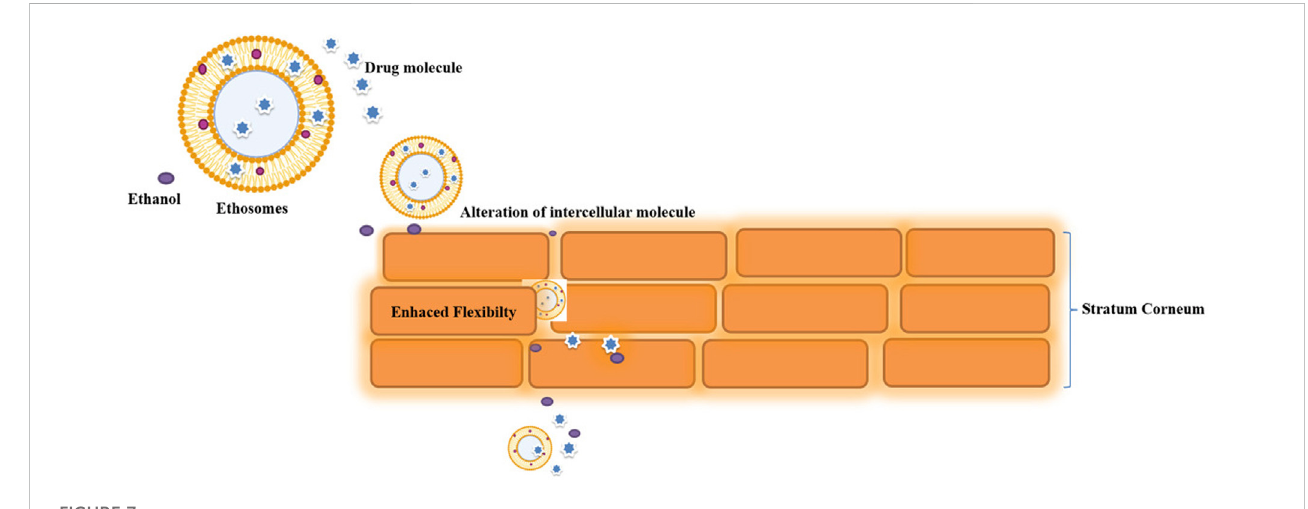
FIGURE 7 Permeation mechanism of drug from ethosomes.